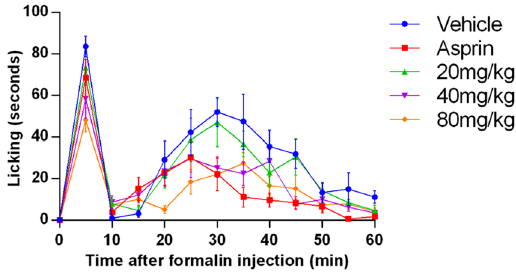
Figure 8. Time course of YM 11 on formalin-induced inflammatory nociception. The drug or vehicle was intravenous injected 30 min before the formalin injection. Values are the means ± SEM.